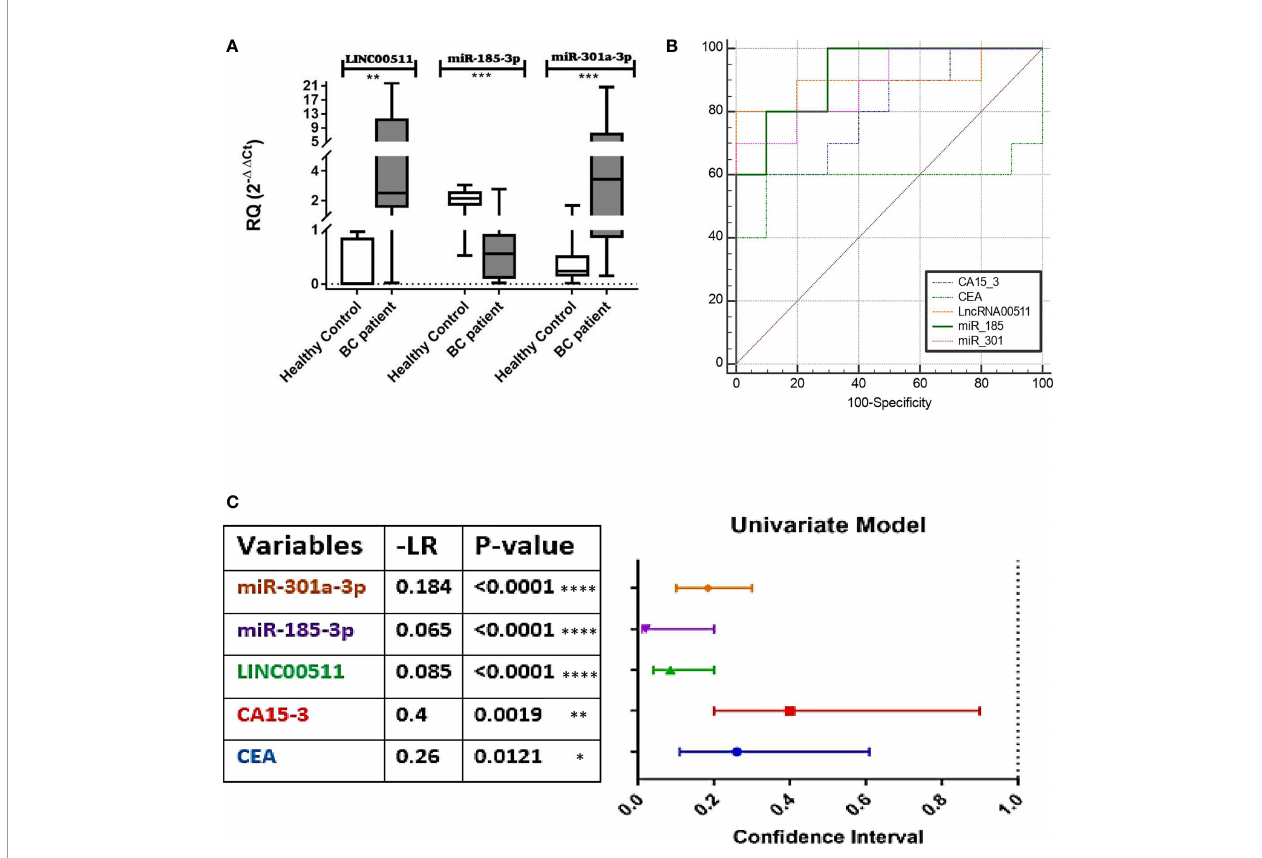
FIGURE 1 | Diagnostic value of LINC00511, miR-185-3p, and miR-301a-3p. (A) Expression levels of targets in BC patients. LINC00511 and miR-301a-3p were signi fi cantly overexpressed, and on the contrary, miR-185-3p was reciprocally downregulated in BC patients, (B) receiver operating characteristic (ROC) curves for the investigated biomarkers, (C) Negative Likelihood Ratios ( − LR) of the estimated markers; estimated % decrease in probability is large (45%) when − LR = 0.1, moderate (30%) when − LR = 0.1 – 0.2, and small (15%) when − LR = 0.2 – 0.5. [All values were obtained using MedCalc software (https://www.medcalc.org/calc). Data were plotted graphically using GraphPad prism software]. **** p < 0.0001. *** p < 0.001. ** p < 0.01. * p < 0.05. RQ, relative expression; BC, breast